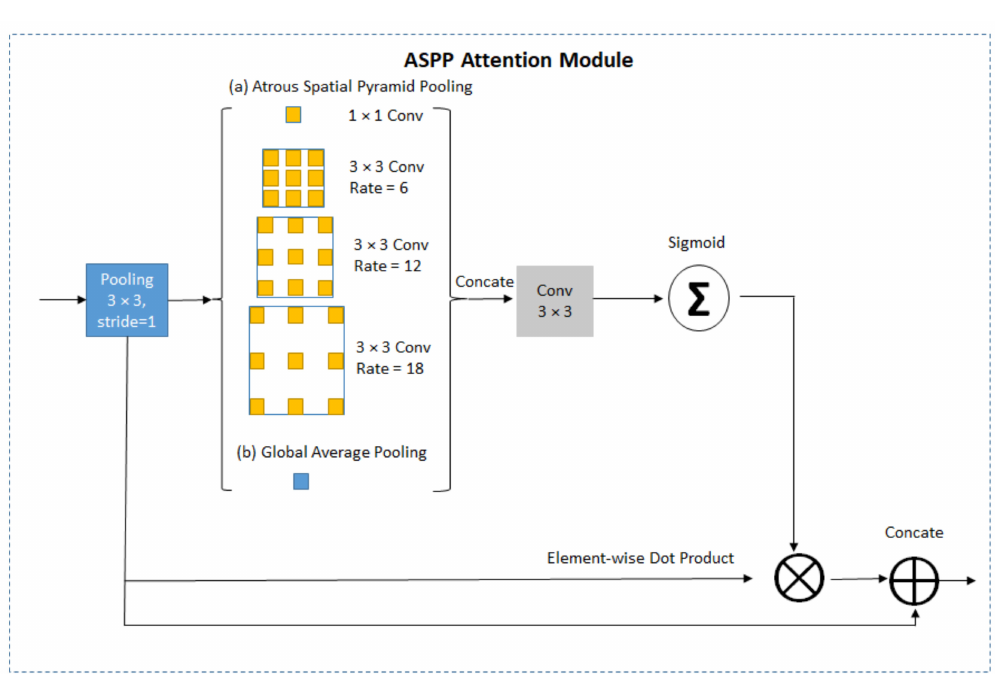
Figure 4. Illustration of Atrous Spatial Pyramid Pooling (ASPP) attention